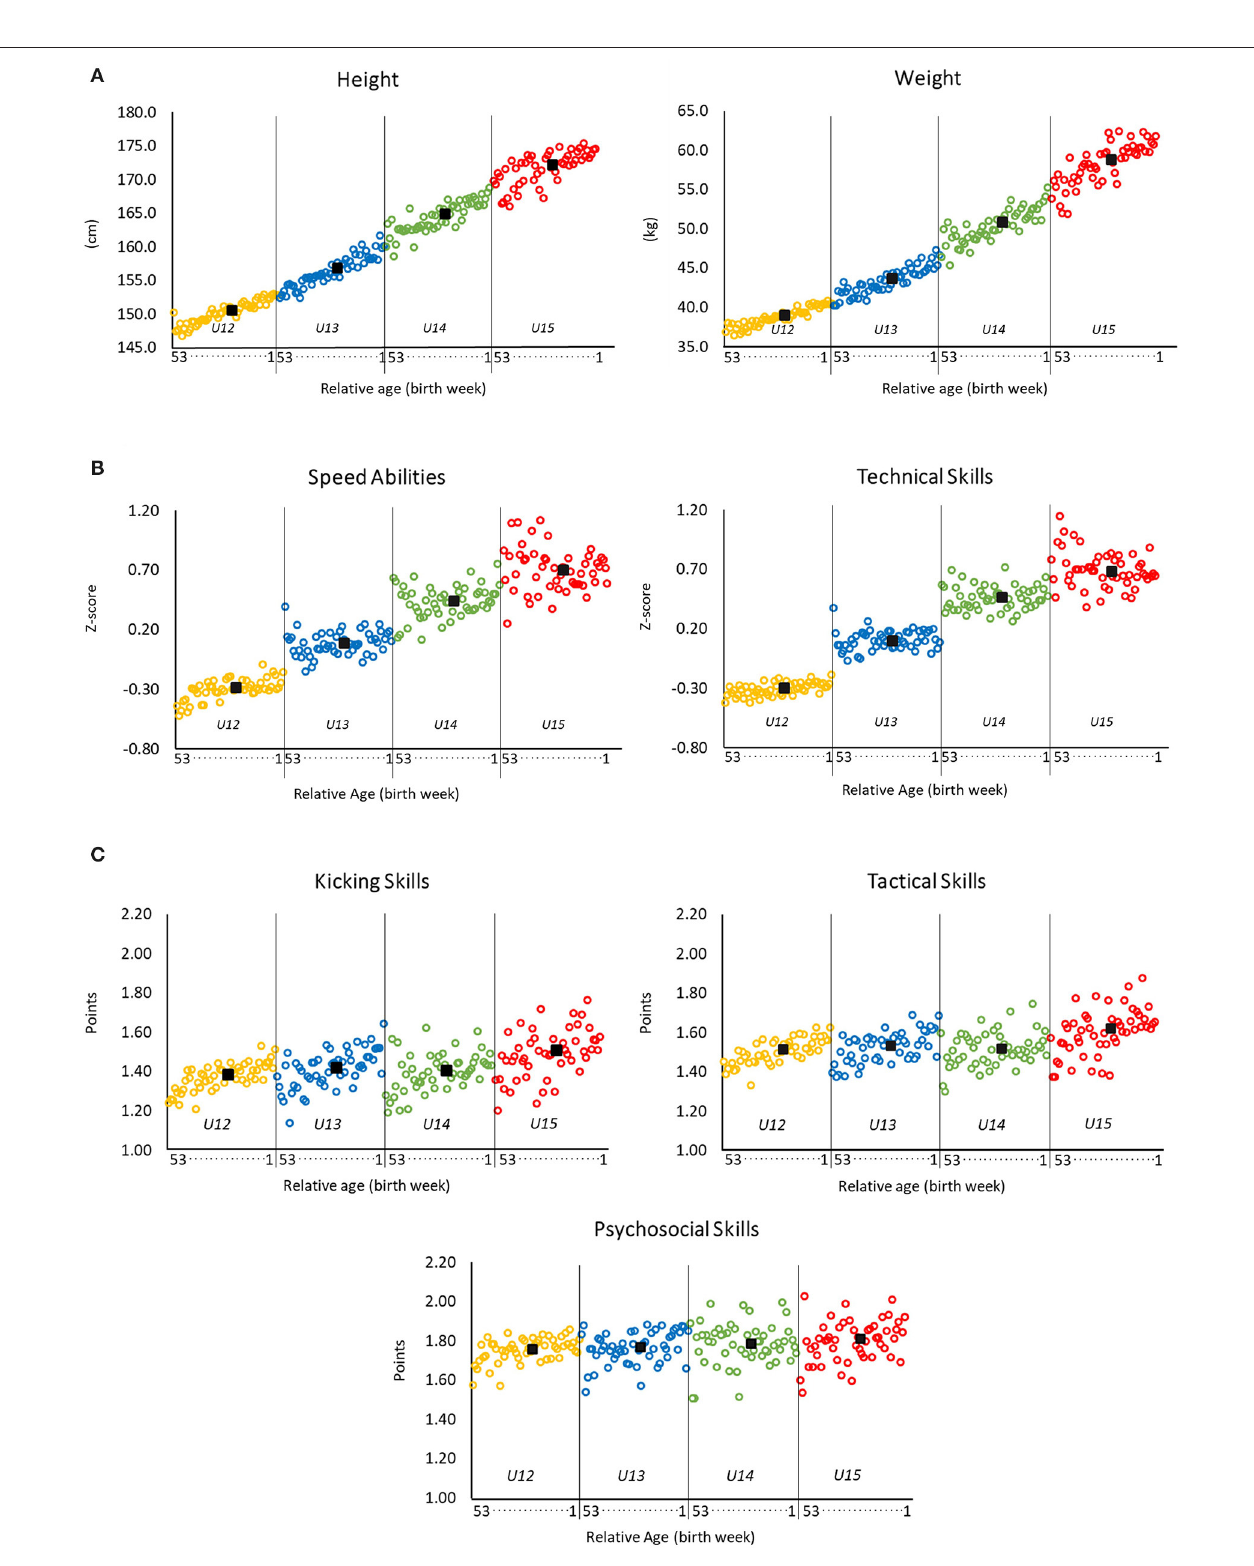
FIGURE 2 | Players’ height and weight (A) , players’ test performances in the objective motor diagnostics (B) , and test results for the subjective evaluations by coaches (C) as a function of relative age (in weeks) ordered by chronological age. Within age groups, results are displayed by increasing relative age (that is, from players born in week 53 within the year to players born in week 1 within the year). Black squares represent the mean value for the respective age group.